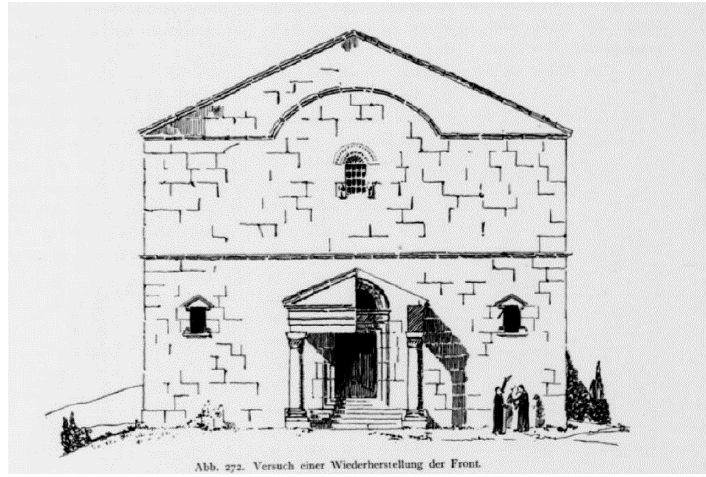
Figure 7. Synagogue in Umm el-Kanatir, theoretical reconstruction by (Kohl and Watzinger 1916, p. 134).